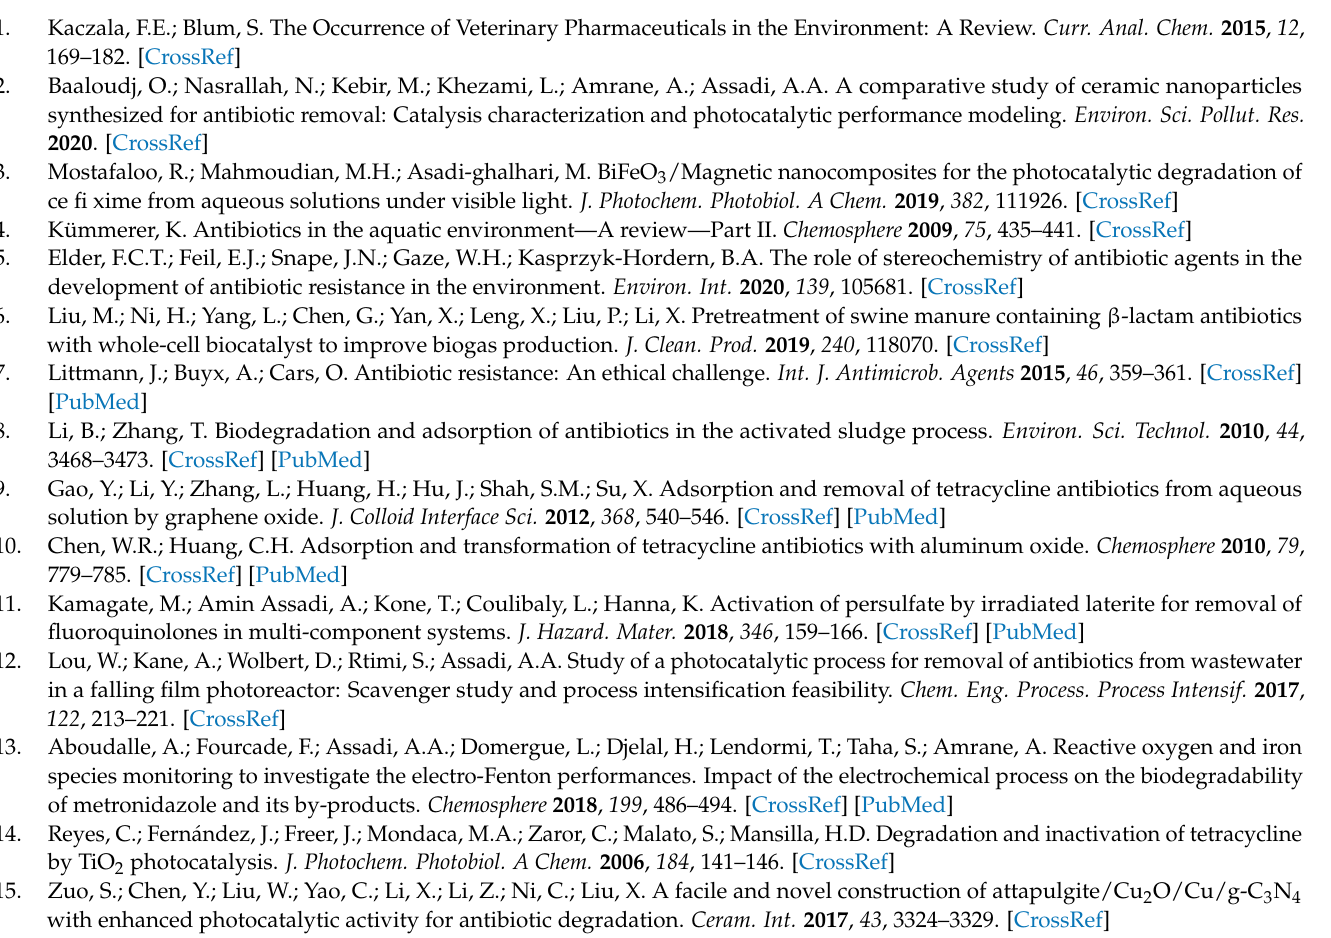
(h ν ), Figure. S6 ε _r as function of λ ˆ2, Figure. S7 Variation of the real and imaginary parts of the optical conductivity as a function of the energy (h ν ), Figure. S8 Semi-logarithmic plot over ZnBi 2 O 4 electrode, Figure. S9 Bode plan (log Z vs. log